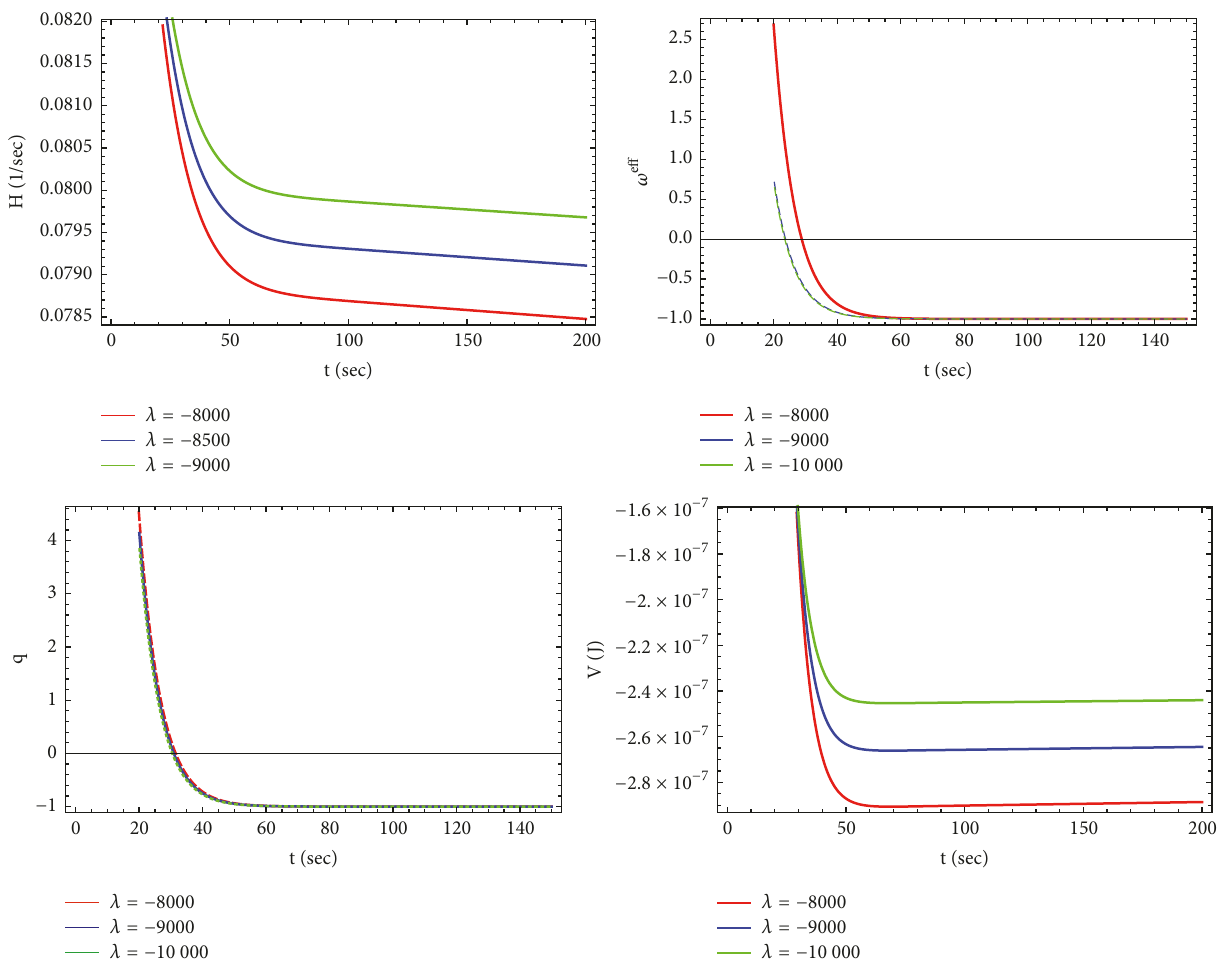
Figure 6: Plots of 𝐻 , 𝜔 𝑒𝑓𝑓 , 𝑞 , and 𝑉 versus 𝑡 for 𝑊(𝜑 − ) = 𝑏 3 sin 𝜑 − , 𝑏 3 = 0.2(1/𝑠𝑒𝑐) , and 𝜑 − (0) = 0.5 when 𝑘 = 1